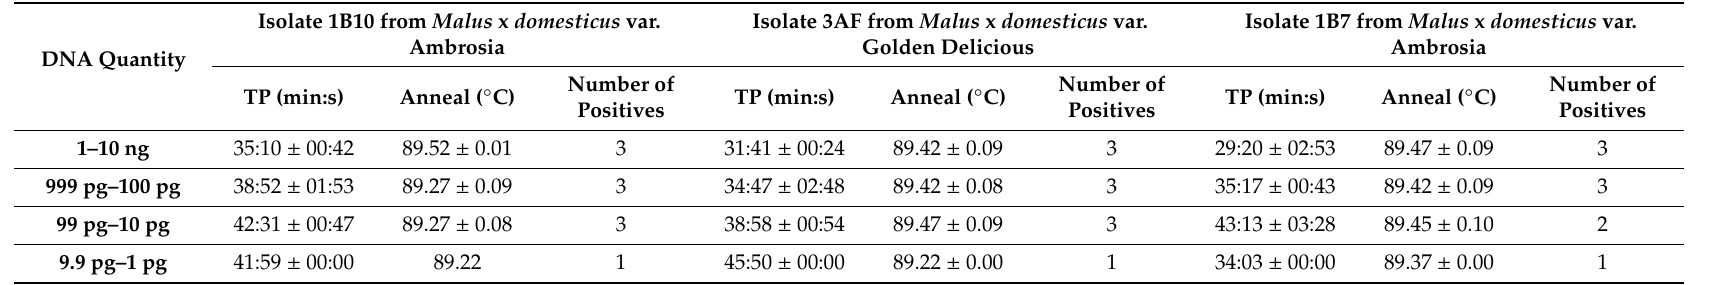
Table 2. Sensitivity test using DNA of three V. inaequalis